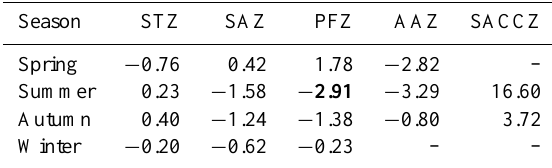
Bold numbers denote statistical significance at the 95% confidence level. In all cases, number of samples is